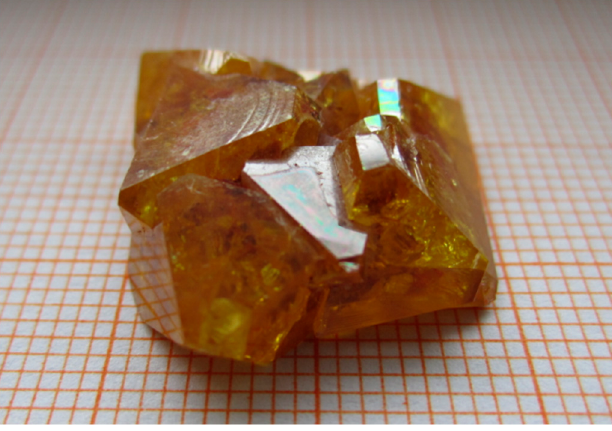
Figure 1. As-grown PLN-0.07PT crystal using the top-seeded solid solution growth (TSSG) method.